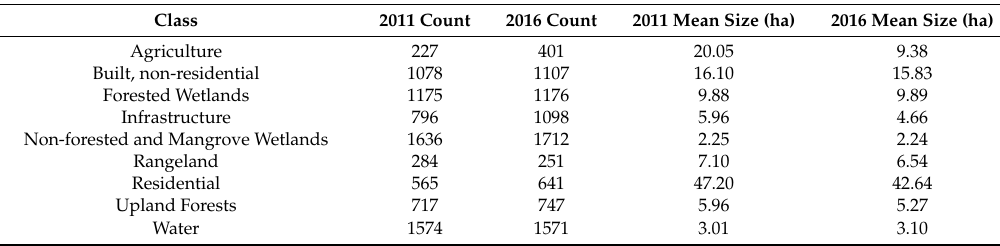
Table 8. Patch counts and mean patch size for LULC classes (ha) from observed data (2011) and after modeled LULC change